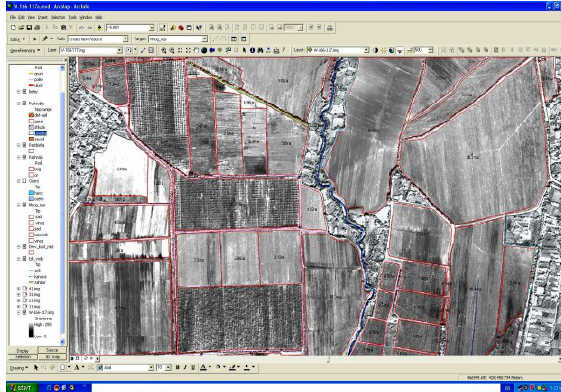
Figure 3. Sample of digital ortho of agricultural area